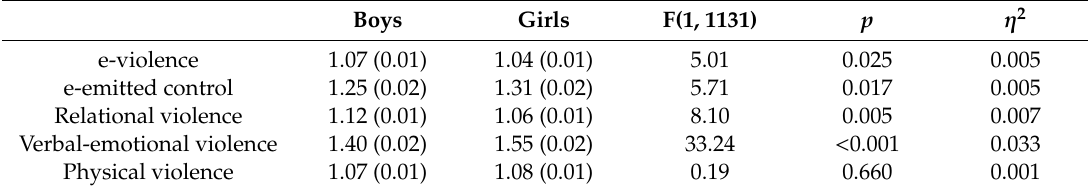
Table 8. Means, standard deviations (in brackets), F values, p values for gender across online and o ffl ine violence ( N = 1132).